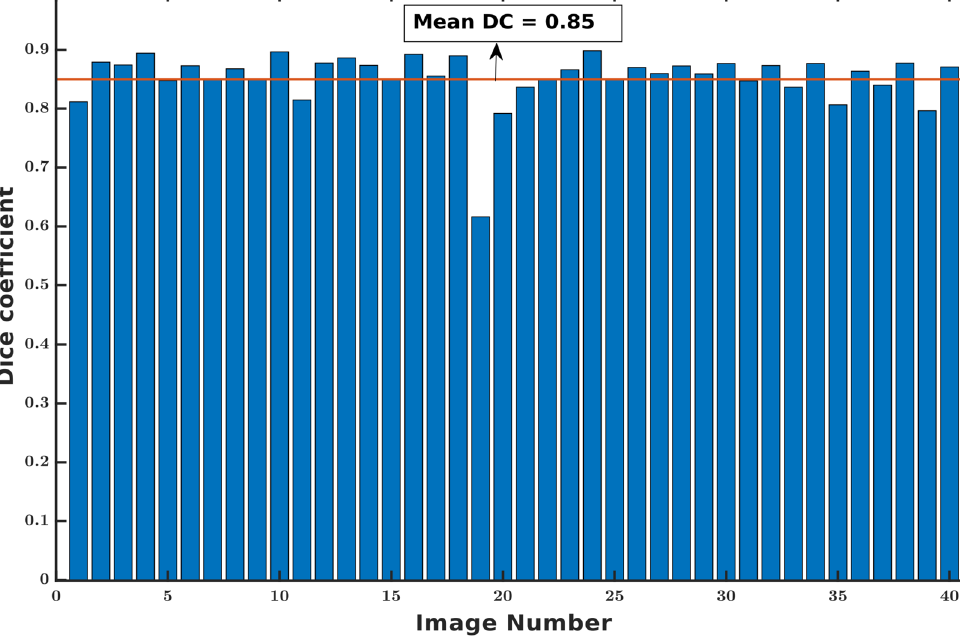
Figure 7. Dice coefficient of faRIA:256 over 40 barley soil-root images from rhizotron imaging system. The orange line represents the mean DC value.